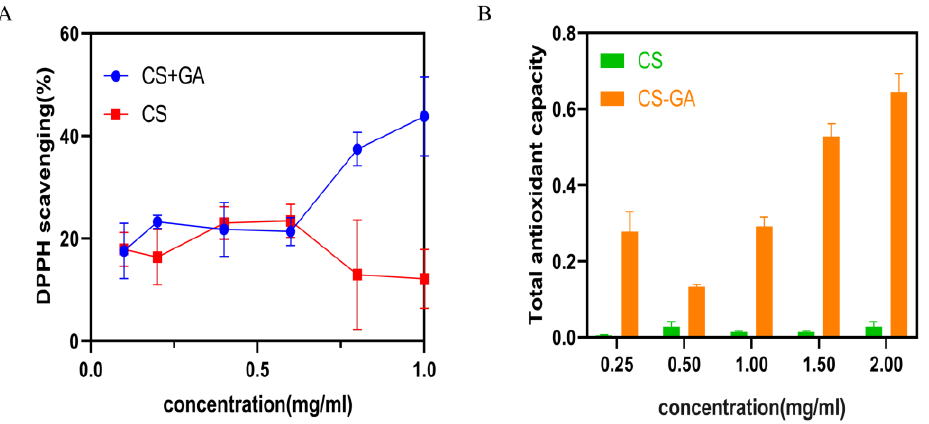
Figure 3. Antioxidant performance of the CS - GA. ( A ) The DPPH scavenging efficiency of CS and CS - GA; ( B ) the total antioxidant capacity of CS and CS - GA.